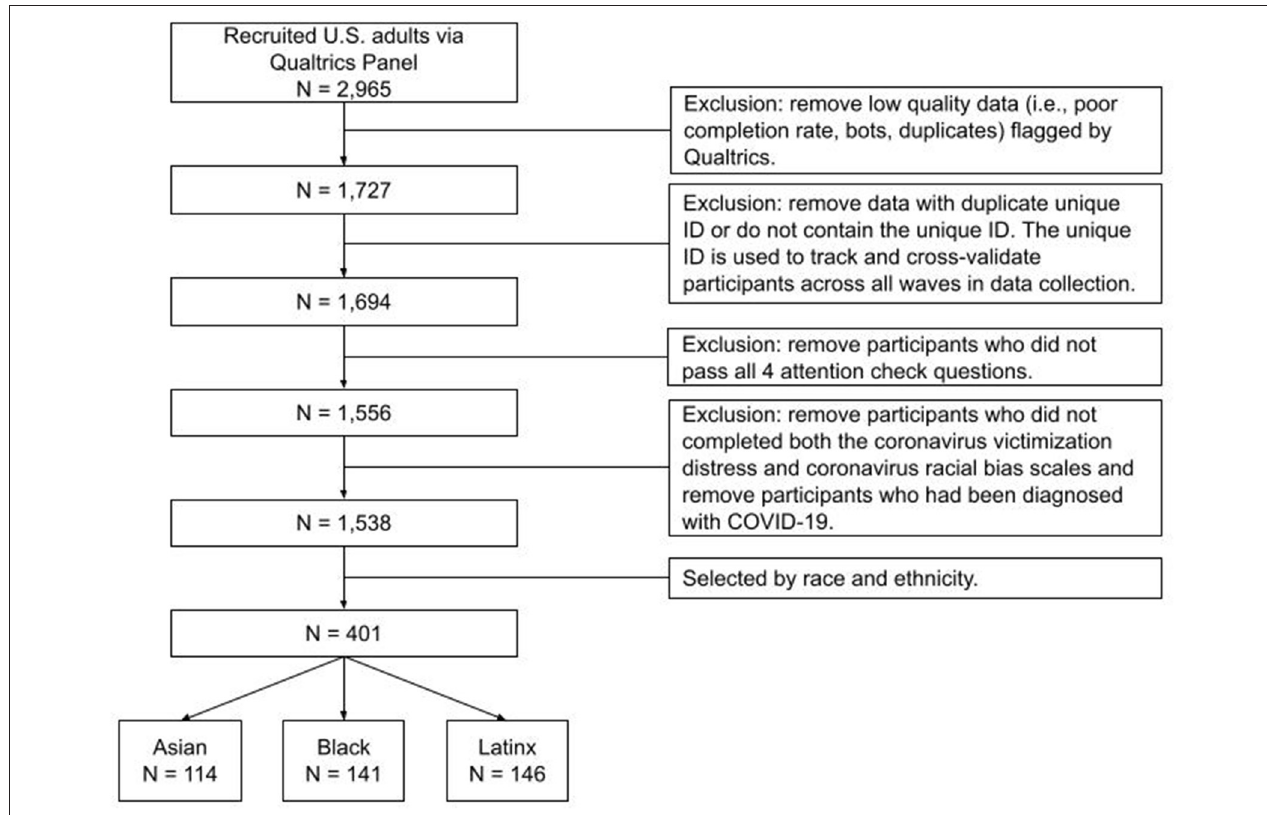
FIGURE 1 | Flowchart of participant recruitment procedure. Participants who met the below three criteria would be invited: showed interests in the current study, use Facebook, age ≥ 18.